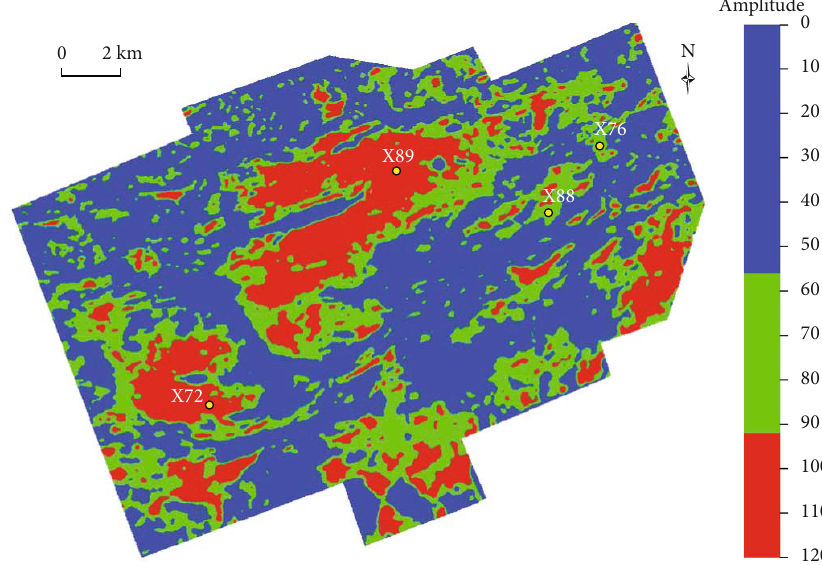
Figure 7: Attribute plan of maximum trough